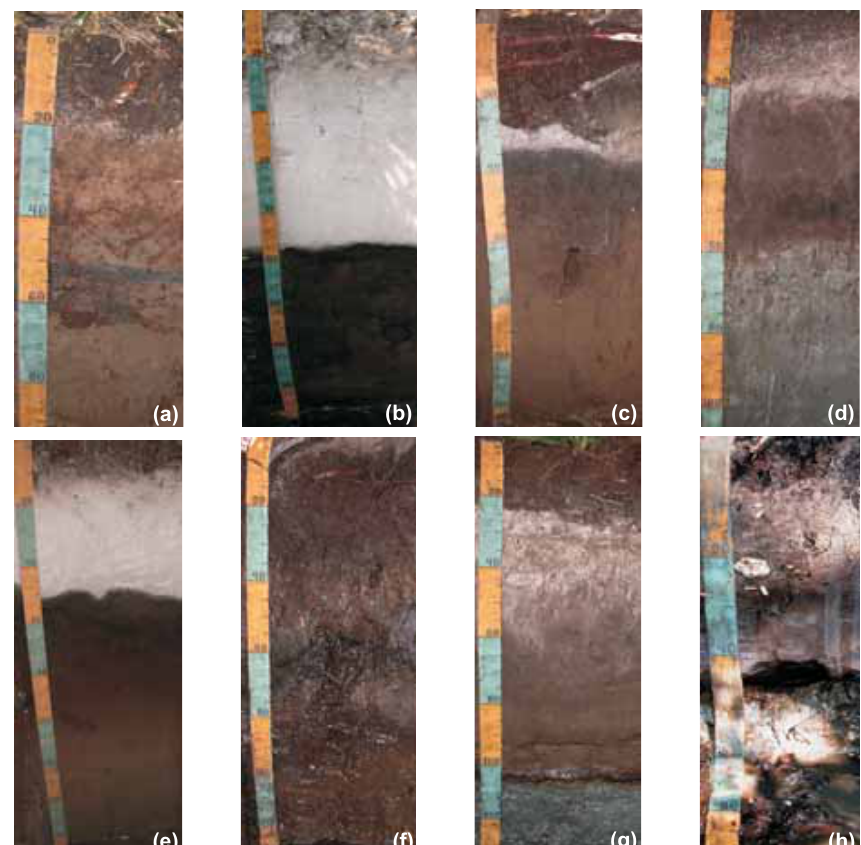
Figura 3. Fotos dos perfis estudados, evidenciando a variação de horizontes dos solos estudados sob vegetação de mata de restinga na Ilha do Cardoso, Cananéia, SP. Na transeção H, o perfil H16 apresenta o horizonte 2Cgj com descontinuidade evidente (d), assim como o perfil P14 da transeção 14 (g). No perfil R14 (h), o ortstein está sobre o horizonte Cgj, erodido.